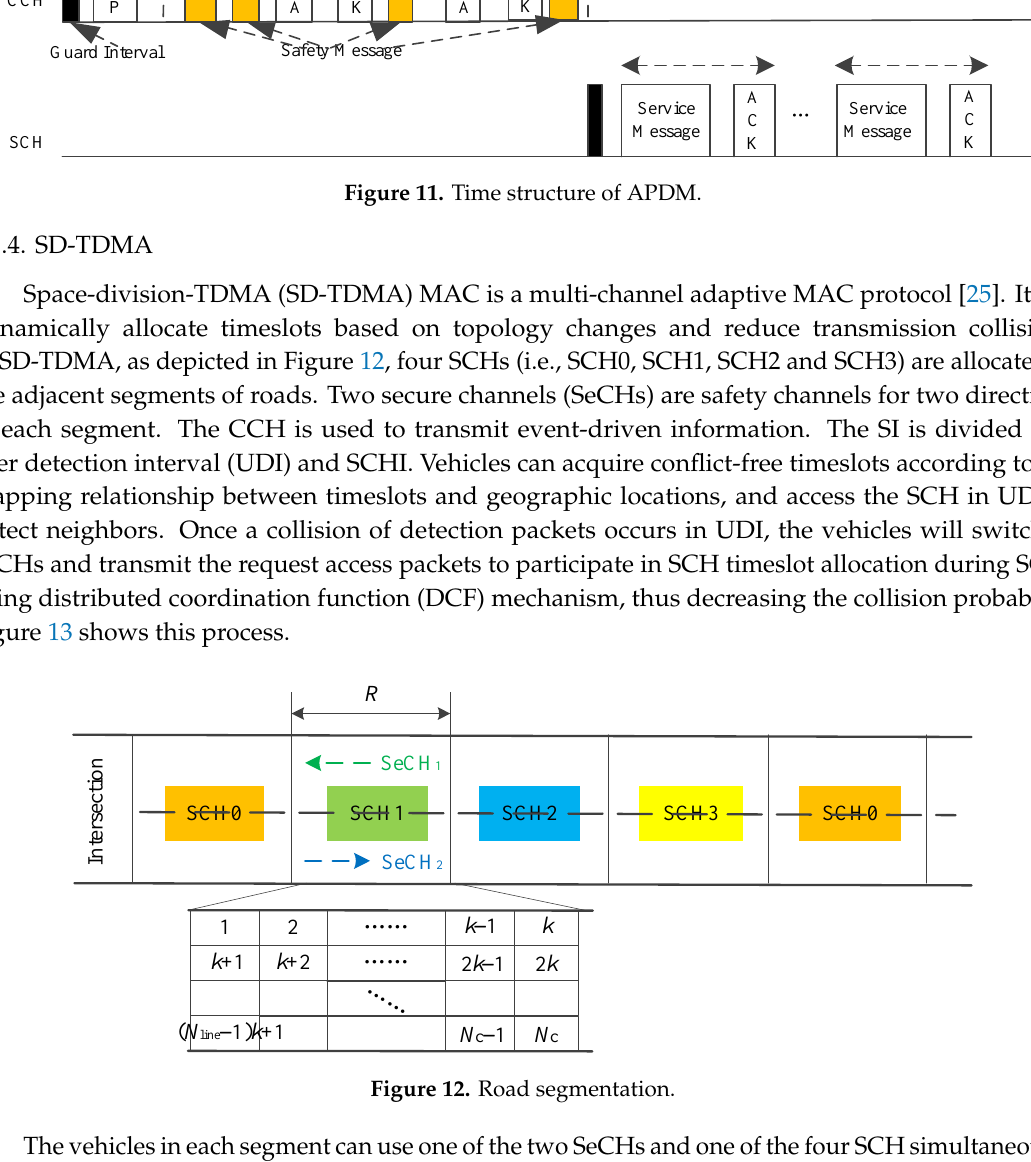
…… Figure 14. Time structure of PCS-AMMAC.